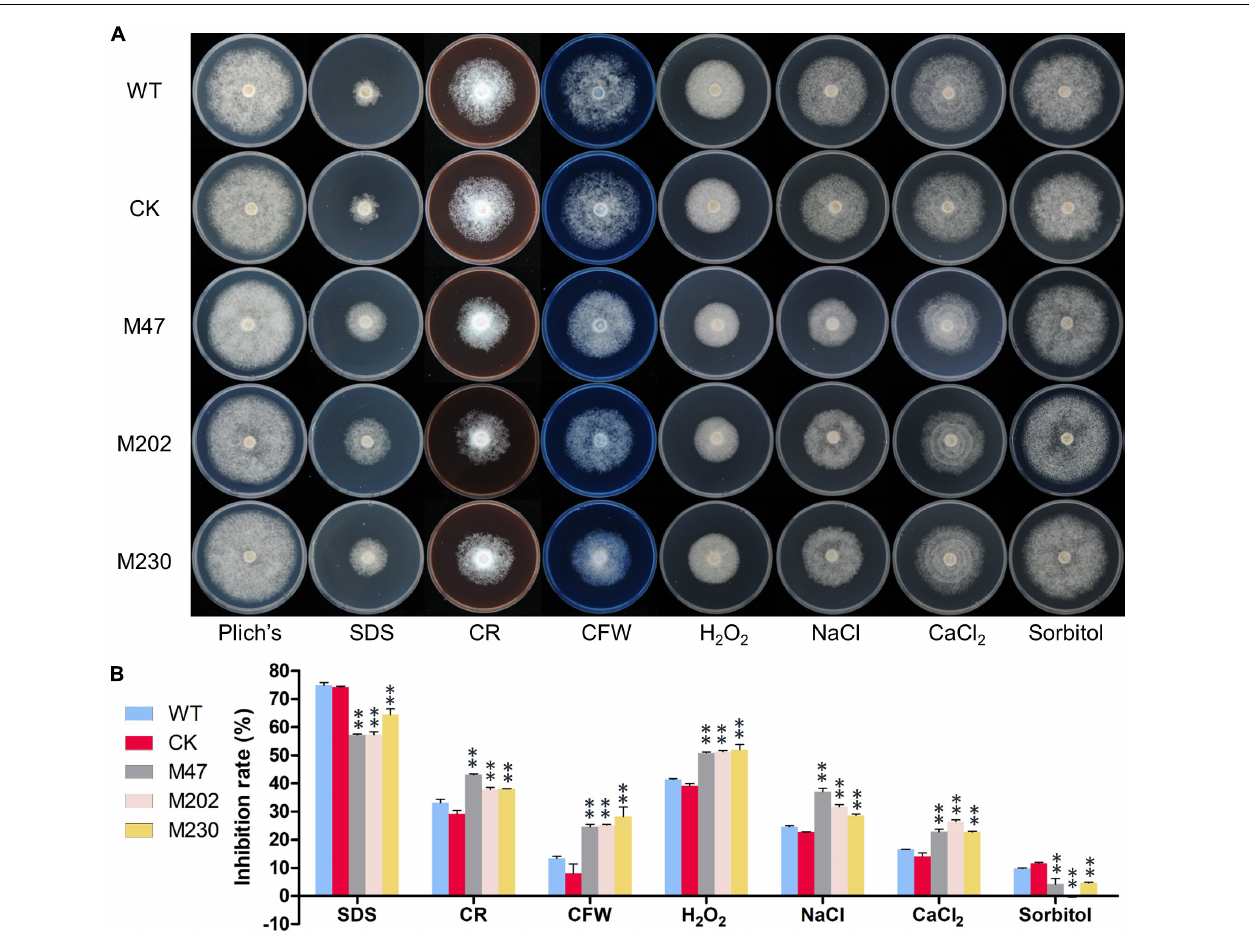
FIGURE 6 | PlCB5L1 is involved in stress tolerance. (A) Assay of mycelial growth of WT, CK, and (cid:49) plcb5l1 mutants on Plich medium only or supplemented with 25 µ g/mL SDS, 350 µ g/mL CR, 100 µ g/mL CFW, 2.0 mM H 2 O 2 , 0.05 M NaCl, 0.1 M CaCl 2 , and 0.2 M Sorbitol. Images were taken 7 days post inoculation. (B) Colony diameters were measured 7 days after inoculation. Rates of growth inhibition were calculated for each treatment relative to growth rate on Plich medium. Data are mean ± SD ( n = 9). and asterisks denote significant differences between (cid:49) plcb5l1 mutants and the WT (** p < 0.01; Duncan’s multiple range